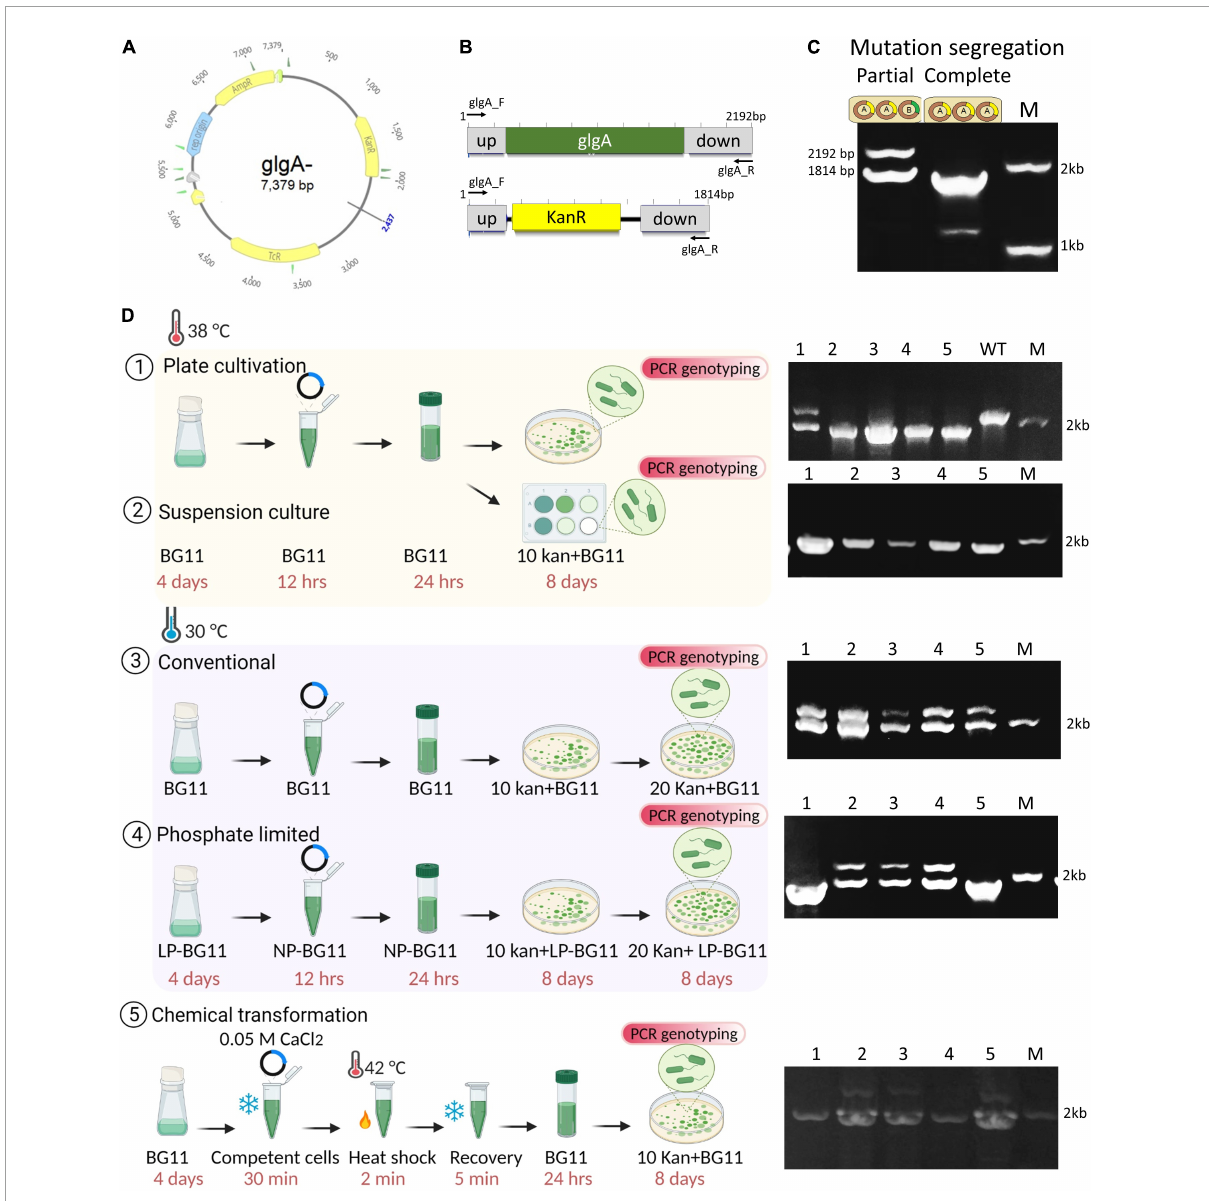
FIGURE3 Transformation of Synechococcus 7942 with (cid:49) glgA gene deletion plasmid. (A) Map of the (cid:49) glgA gene deletion construct obtained from Addgene (plasmid#101841). (B) The integration site and primer binding sites are coloured grey, the glgA gene is shown in green, and the kanamycin (Kan) resistance gene is shown in yellow. (C) Agarose gel for the PCR with the primer pair (glgA_F (MDLJCSTR159) and glgA_R (MDLJCSTR160) shows complete and partial transgene segregation. (D) Schematics of transformation protocol and validation of mutants by PCR genotyping. Cultures of Synechococcus 7942 used for transformation were taken from three conditions; 38 ◦ C, 30 ◦ C, and phosphate-limited BG-11. Suspension culture and traditional plating methods of transformation were tested. Validation of segregated mutants was performed using the primer pair glgA_F and glgA_R. High temperature produced most of the fully segregated mutants. No fully segregated mutants were obtained at 30 ◦ C. Phosphate-depleted cultures produce nearly 50% of segregated mutants. Chemical transformation of Synechococcus 7942 was successfully performed using 0.05 M CaCl 2 . Created with BioRender.com.